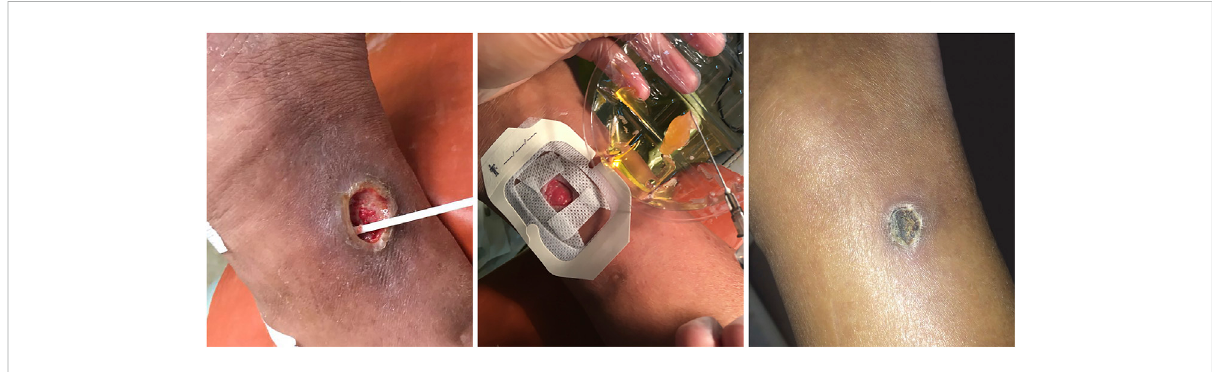
FIGURE 2 The diabetic lower extremity ulcer successfully healed with allogenic PRP. The patient with diabetic lower extremity ulcer was topical administrated with allogenic PRP. After 21-day treatment, the ulcer was completely